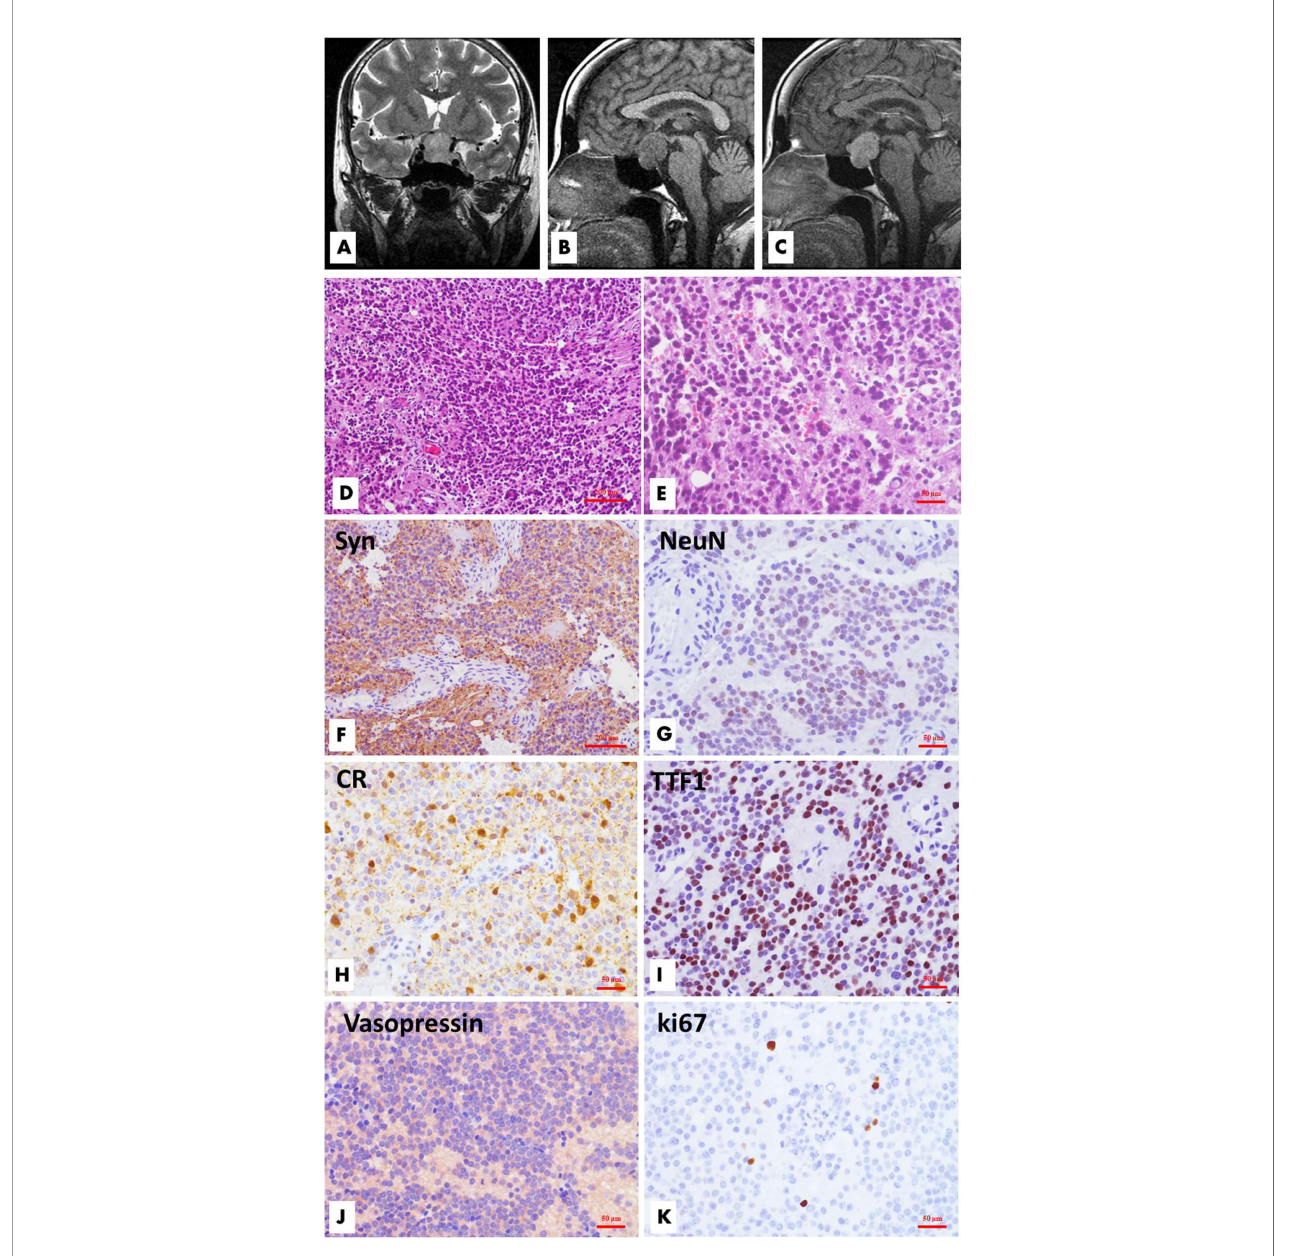
FIGURE 1 | Radiological, histological and immunohistochemical features of sellar/suprasellar neurocytoma (Case 1). MR imaging demonstrated a well-circumscribed mass located in the sellar and suprasellar regions. The tumor was inhomogeneously hyperintense on coronal T2WI, and the left suprasellar sinus space was involved (A) , while the lesion was hypointense on sagittal T1WI, and the optic chiasma was displaced upwardly (B) . The lesion showed signi fi cant homogeneous enhancement on enhanced T1WI (C) . Microscopically, the tumor is comprised of solid nests or sheets of noncohesive monotonous small round cells with round to oval nuclei and fi ne chromatin. The poorly de fi ned cytoplasm merges with the neuropil. Necrosis and mitotic fi gures are absent. (D , H&E, ×100; E , H&E, ×200 ) Immunohistochemical analysis revealed that the tumor cells had neuronal differentiation and were positive for synaptophysin (F , ×100 ) , NeuN (G , ×200 ) , and calretinin (H , ×200 ) . TTF1 (I , ×200 ) and vasopressin (J , ×200 ) had variable reactivities. The Ki-67 labeling index is approximately 1.5% (K , ×200 )